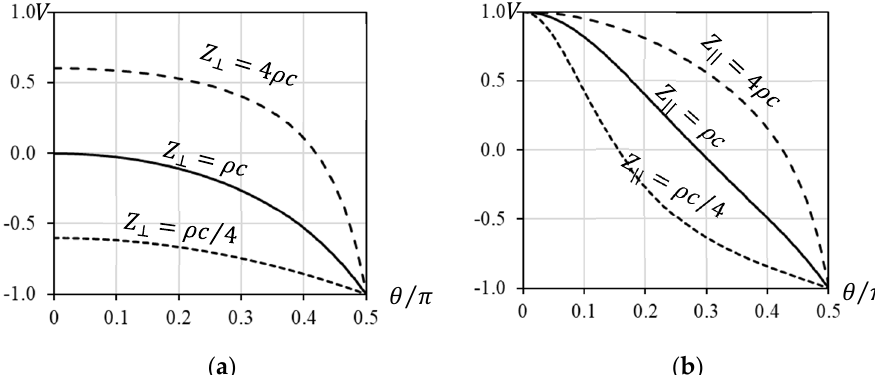
Figure 6. The reflection coefficients of the surfaces with normal ( a ) and tangential ( b ) impedances.